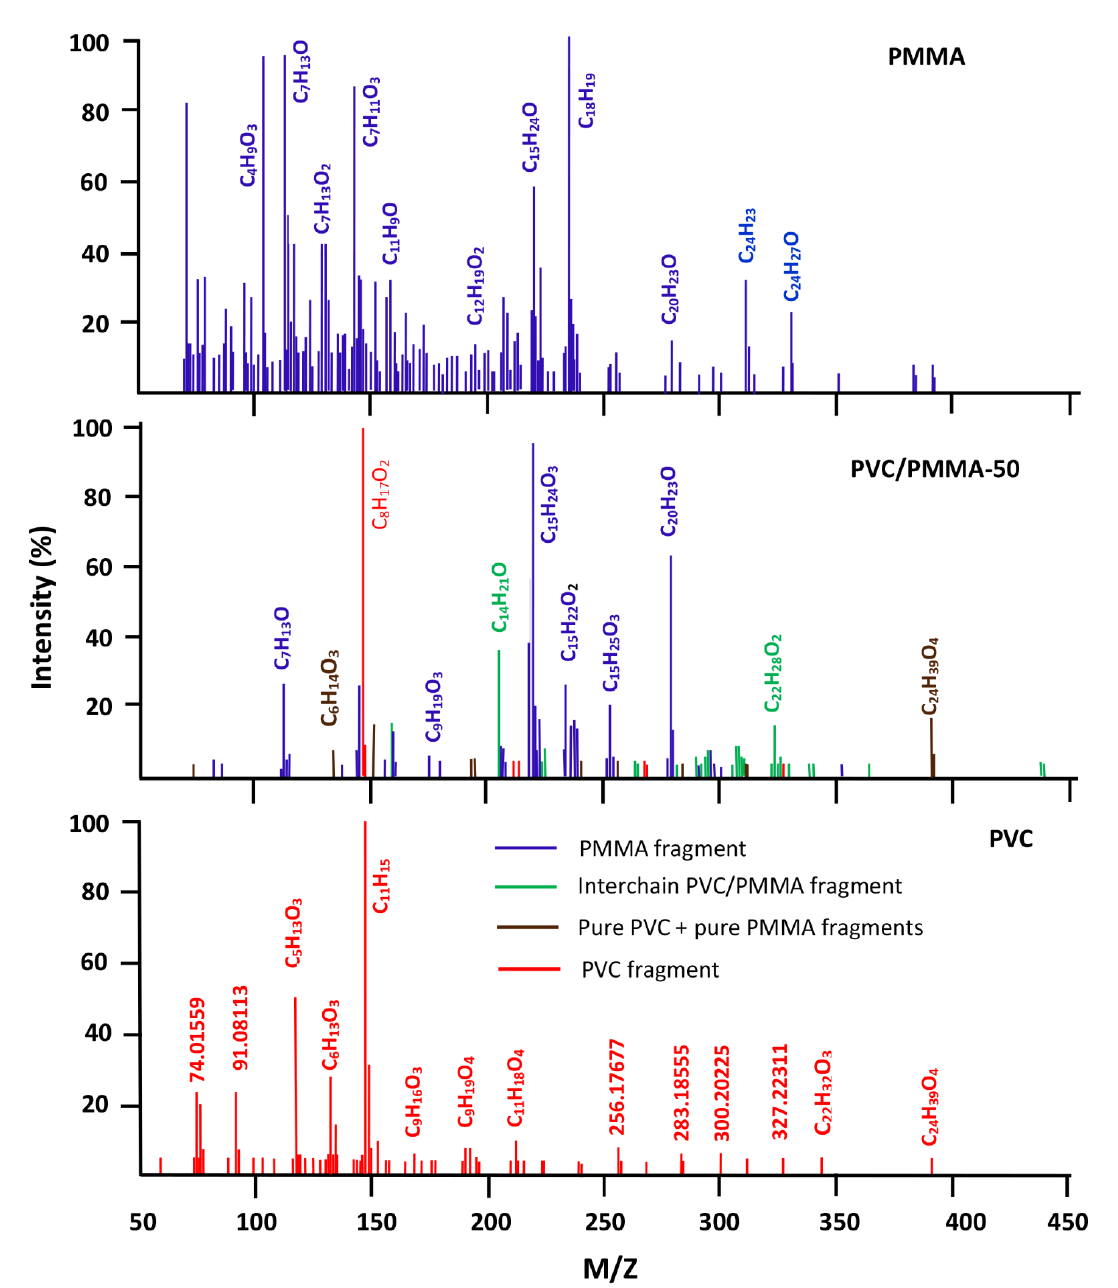
Figure 12. Comparative spectra of pure PVC, PMMA, and their blend with 50 wt% of each com- ponent.